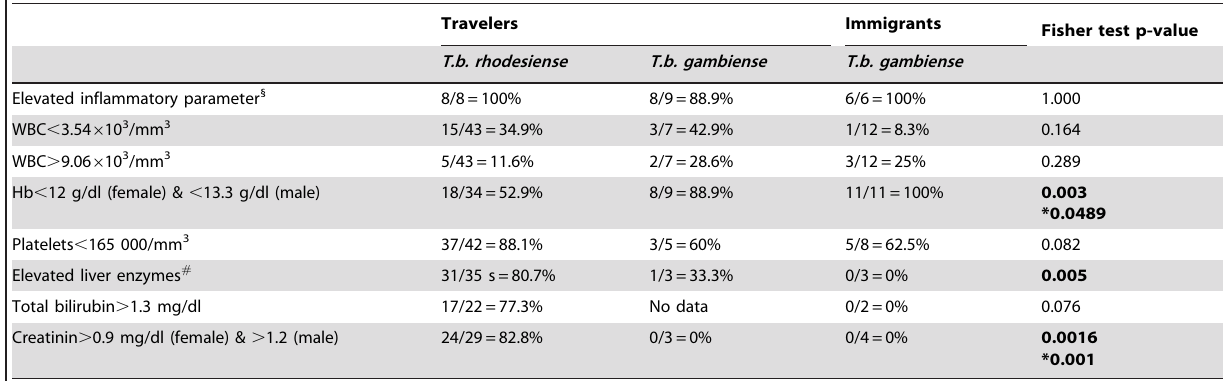
Table 4. Laboratory parameters.